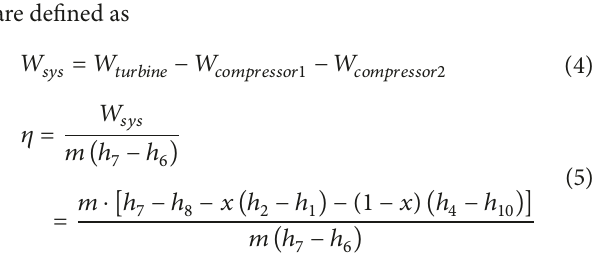
One stream flows through a condenser (10-1) and then through the compressor 2 (1-2), while the other stream flows through the compressor 1 (10-4). The flow out of compressor 2 enters regenerator 2 and is preheated to the same temperature as the outlet of compressor 1 (3-4). Then, the flow stream from regenerator 2 merges with the flow stream from compressor 1 (point 5), and the combined flow stream is further preheated in the regenerator 1 to the LBE-CO 2 heat exchanger inlet temperature (5-6) to complete the